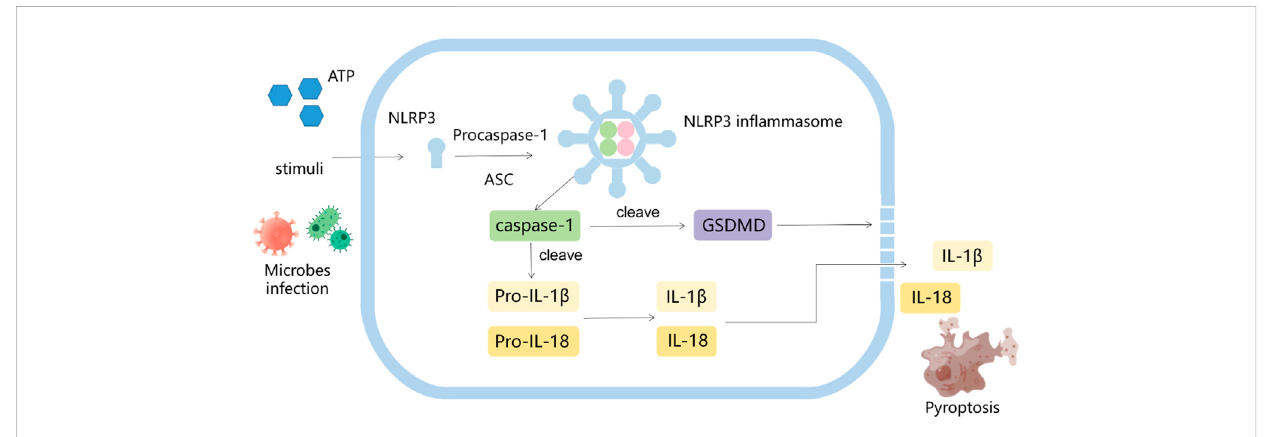
FIGURE 1 The diagram of activation process of